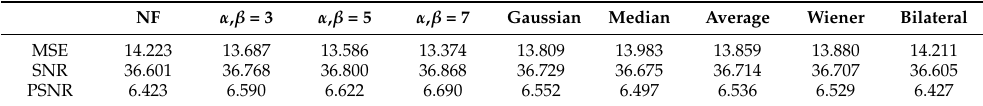
Table 1. Numerical comparison using MSE, SNR, and PSNR between the ideal target and 3D profile results by various